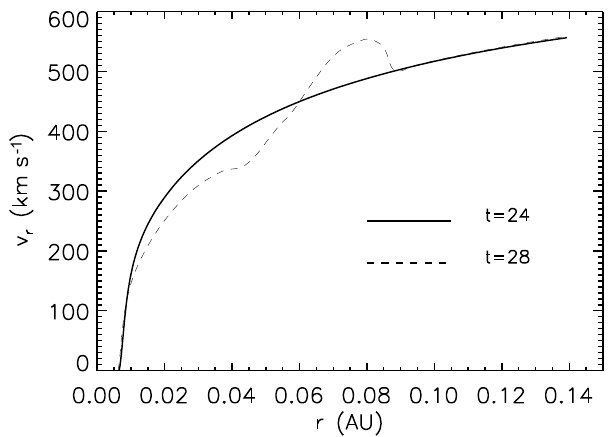
Figure 2. Plasma radial velocity profiles in the model along the direction θ = 67 ◦ , φ = 189 ◦ at the initial time of the CME ( t = 24) and 0.25 days later ( t =